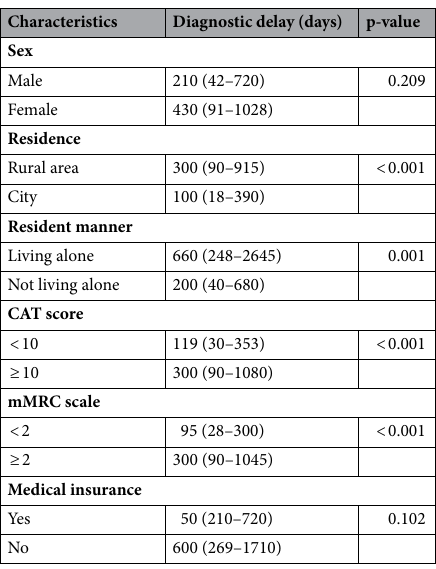
Table 3. Wilcoxon test for demographic differences in diagnostic delay. CAT , COPD Assessment Test, mMRC , modified Medical British Research Council, PFT pulmonary function test.